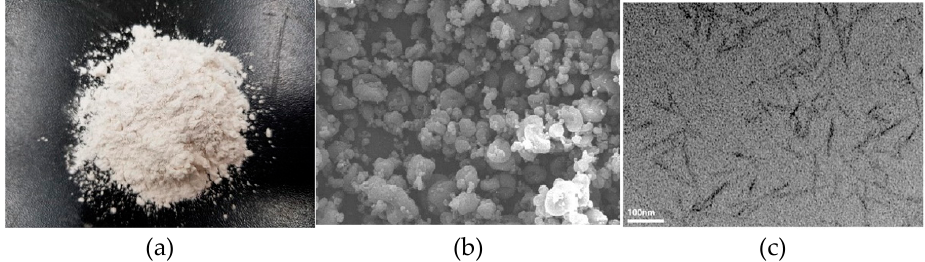
Figure 4. ( a ) Raw CNCs; ( b ) their scanning electron microscopy image; ( c ) transmission electron microscope image of dispersed CNCs. Reproduced from Lee et al. [66] with permission from Elsevier.